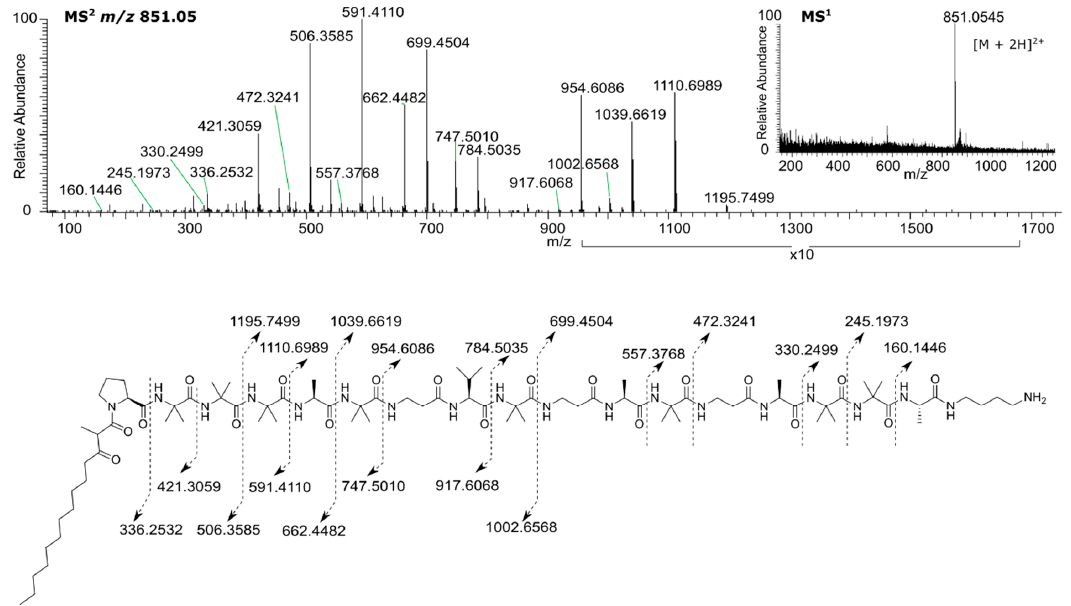
Figure 4. HRMS for sphaerostilbellin B ( 2). Table 2. 1 H- and 13 C-NMR data for compound 2 in DMSO- d 6 (500 and 125 MHz for 1 H- and 13 C-, respectively).